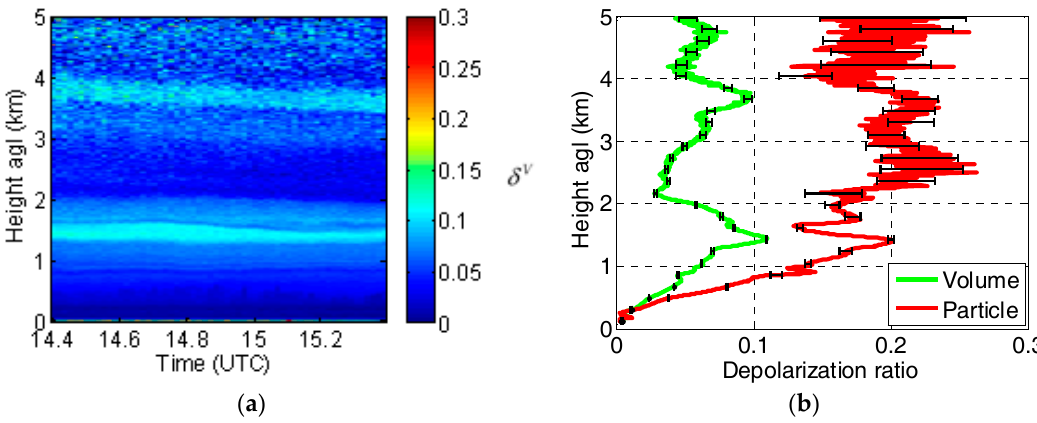
Figure 8. Depolarization ratios measured with the UPC multi-wavelength lidar during the 26 May 2016 Saharan dust intrusion event: ( a ) quicklook of the volume depolarization ratio between 14:24 and 15:23 UT with a time resolution of 1 min.; ( b ) average vertical profile of the volume (green) and particle (red) depolarization ratios with their associated error bars (black).